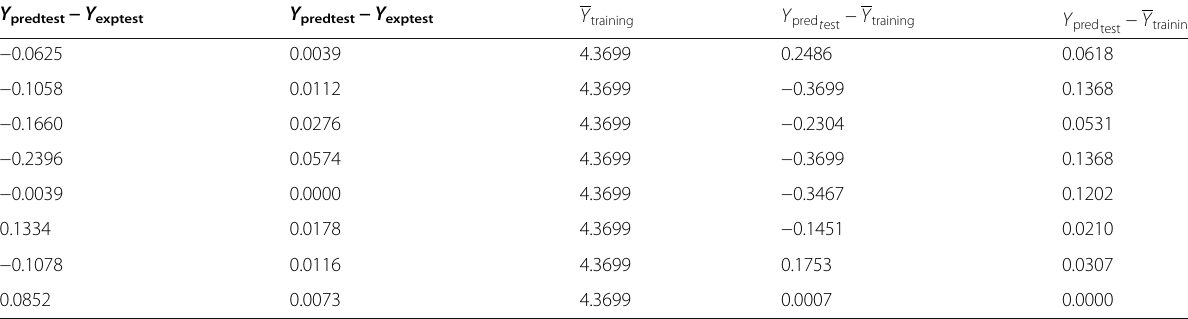
Table 6 Calculation of the predicted R 2 of developed model